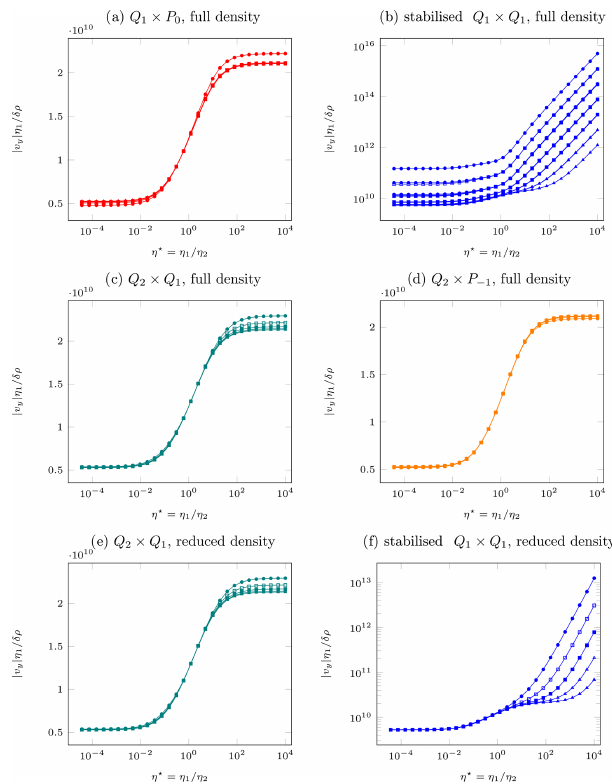
Figure 11. Sinking block benchmark. (a–d) ν = | v z | η 1 /δρ as a function of η (cid:63) = η 2 /η 1 as obtained with the four elements with full density; (e, f) same with reduced density for only two element types. Legend: • 16 × 16 resolution, (cid:3) 32 × 32 resolution, (cid:4) 64 × 64 resolution, (cid:52) 128 × 128 resolution, (cid:78) 256 × 256 resolution. Colors represent the element used. For each mesh resolution, we show sep- arate curves for δρ/ρ 1 ∈ { 0 . 25% , 1% , 4% } ; for all but the stabilized Q 1 × Q q element, these curves coincide. Note the different y axis used for the stabilized Q 1 × Q 1 element in (b) and (f)